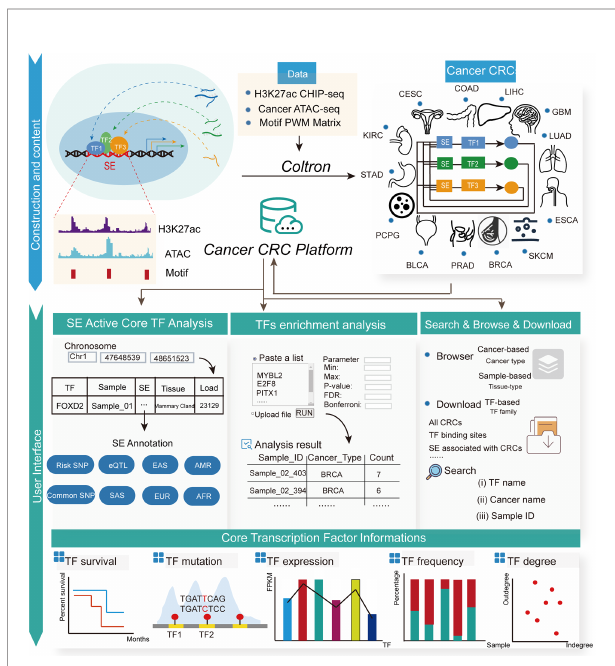
FIGURE 1 | The user interface of the Cancer CRC platform. The Cancer CRC provides CRCs and core TFs for 13 types of cancer, including bladder urothelial carcinoma, breast cancer, colon adenocarcinoma and esophageal carcinoma, among others. The Cancer CRC supports multiple functions, including search, download, browse and enrichment analysis. Additionally, for core TFs, there is extensive annotation information, such as TF survival, mutations, expression, frequency and degree in